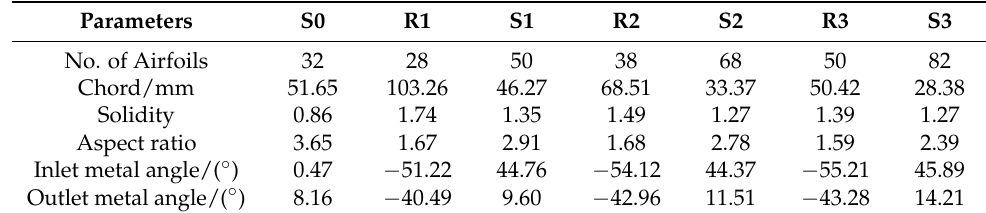
Figure 5. Flow path. Table 1. Main blading parameters of the compressor.